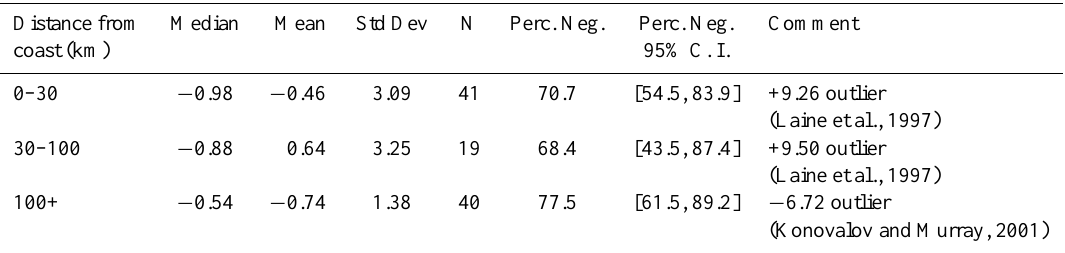
Table 3. Oxygen trend statistics (µmolL − 1 yr − 1 ) from published time series in various ranges of distances from the coast, using data from the entire time series. Abbreviations: C. I. = confidence interval; Std Dev = standard deviation; N = number of time series; Perc Neg = Percentage of negative trends.